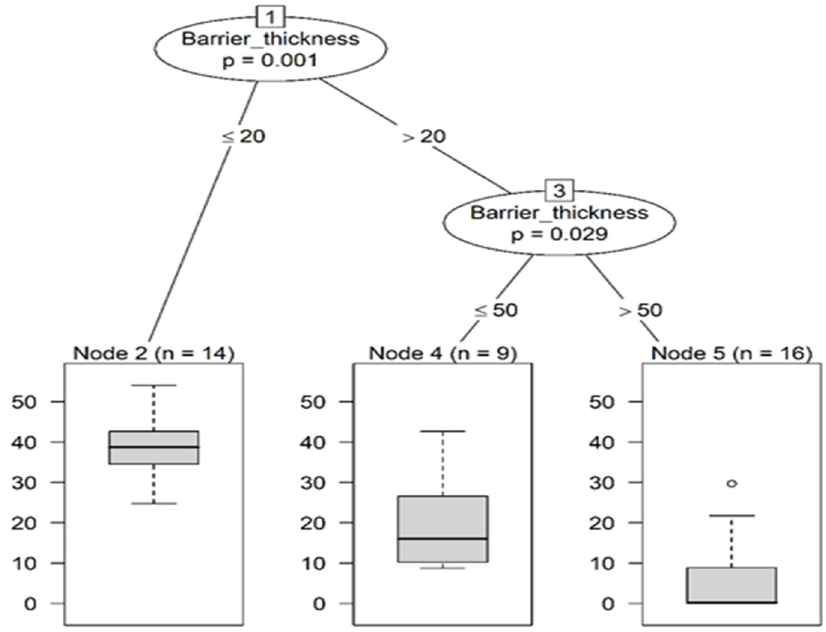
Figure 4. The CIT model for saline groundwater supply (Node 2 = 39.21 cm yr − 1 , Node 4 = 20.14 cm yr − 1 , and Node 5 = 5.57 cm yr − 1 ).